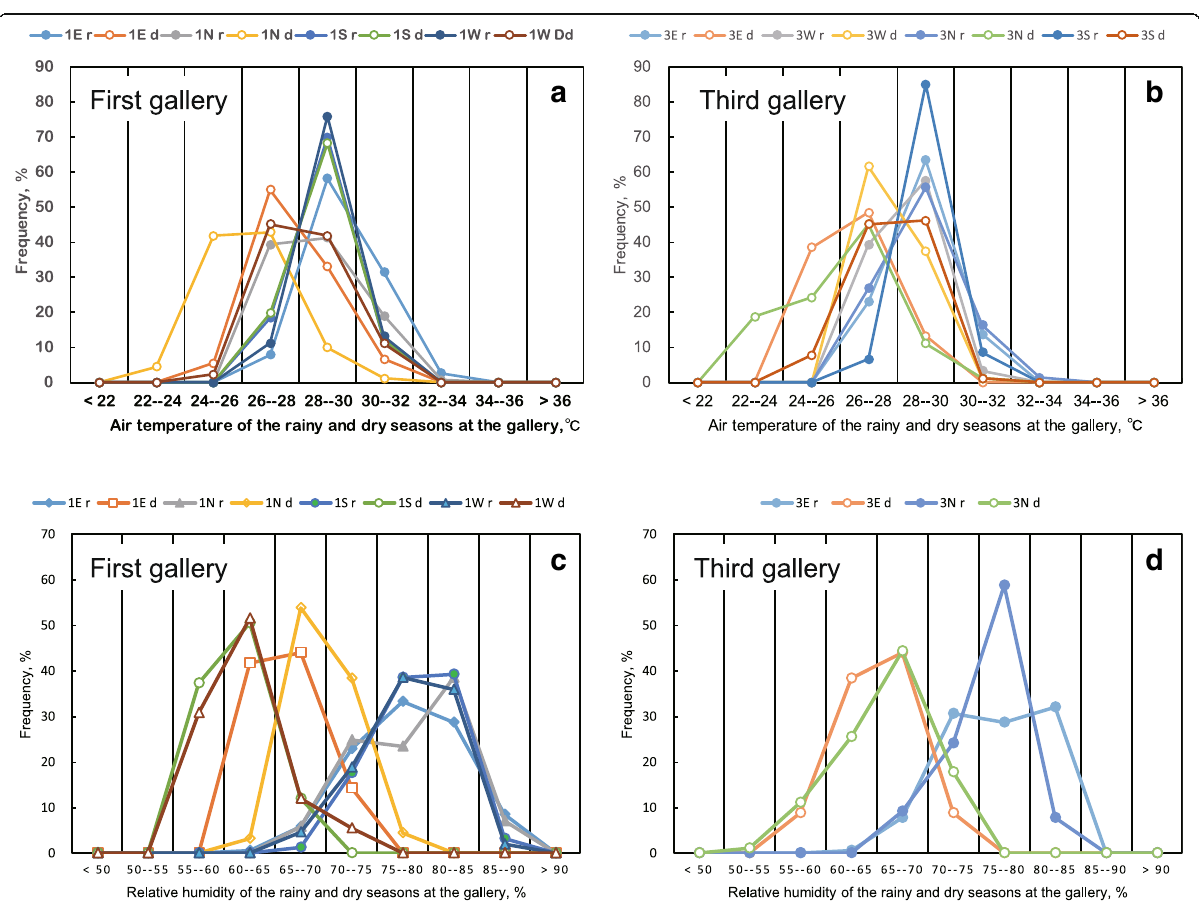
Fig. 9 Temperature and relative humidity frequencies of the galleries in the rainy and dry seasons. a Frequency of the temperature at the first gallery. b Frequency of the temperature at the third gallery. c Frequency of the relative humidity at the first gallery. d Frequency of the relative humidity at the third gallery. In the legend; r rainy season (from June to October), d dry season (from December to